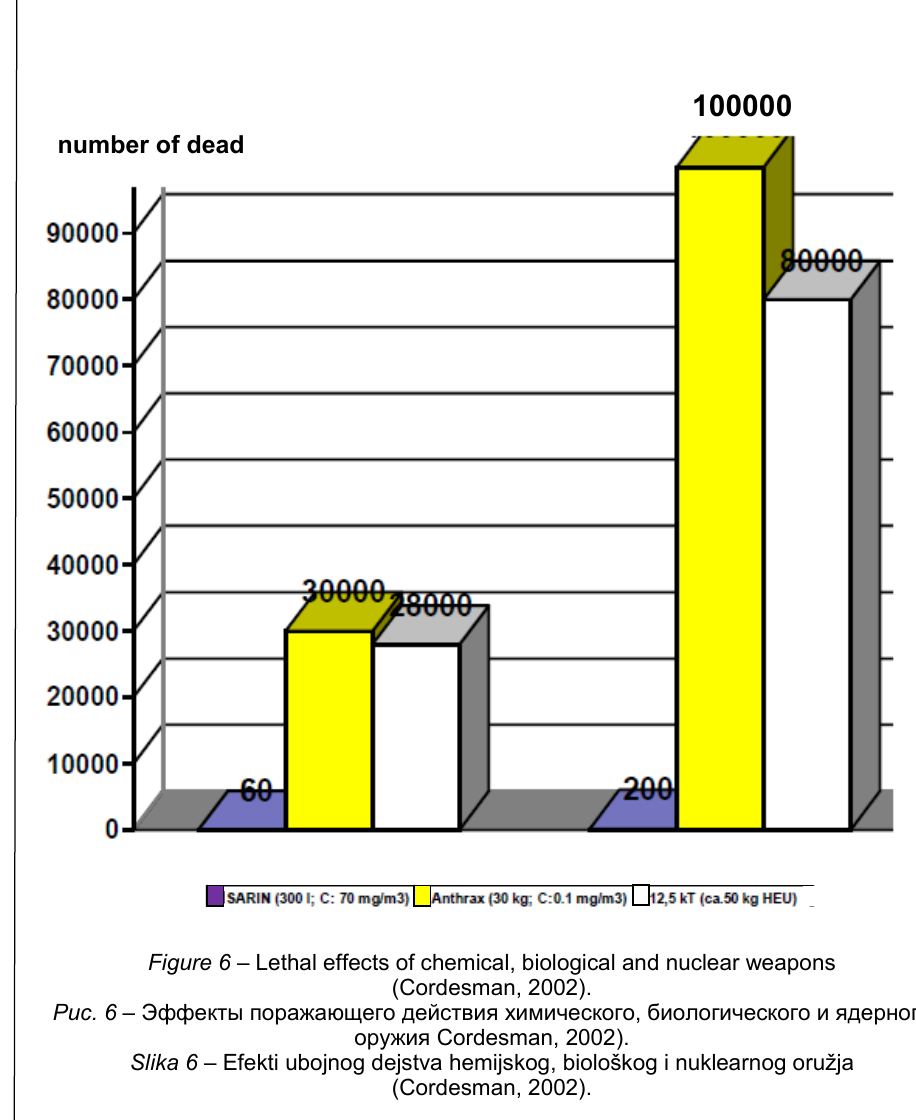
Figure 6 – Lethal effects of chemical, biological and nuclear weapons (Cordesman, 2002). Рис . 6 – Эффекты поражающего действия химического , биологического и